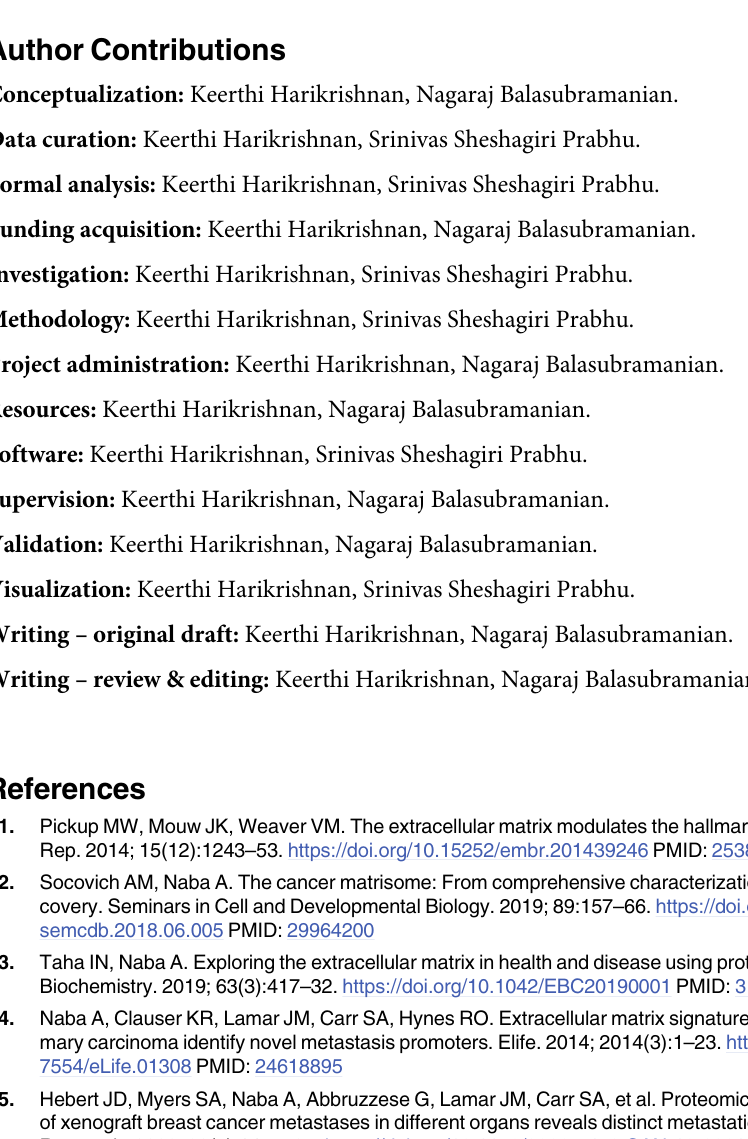
S1 Fig. Protein categories of the functional network analysis of CTHRC1 and its 5 hub genes. Nested bar graphs represent the percentage of proteins that belong to each category in (A) the network analysis based on query genes, (B) co-expression network based on biological processes or (C) cellular component and physical interaction network based on (D) biological processes or (E) cellular component. Each colour represents a distinct protein subcategory. (PDF) S1 File. S1A is the summary file of the top 5% genes for 9 cancers. S1B - S1J are the raw data output files of the differential gene expression analysis of the 9 cancers (Fig 4A) where CTHRC1 is upregulated and affects survival.